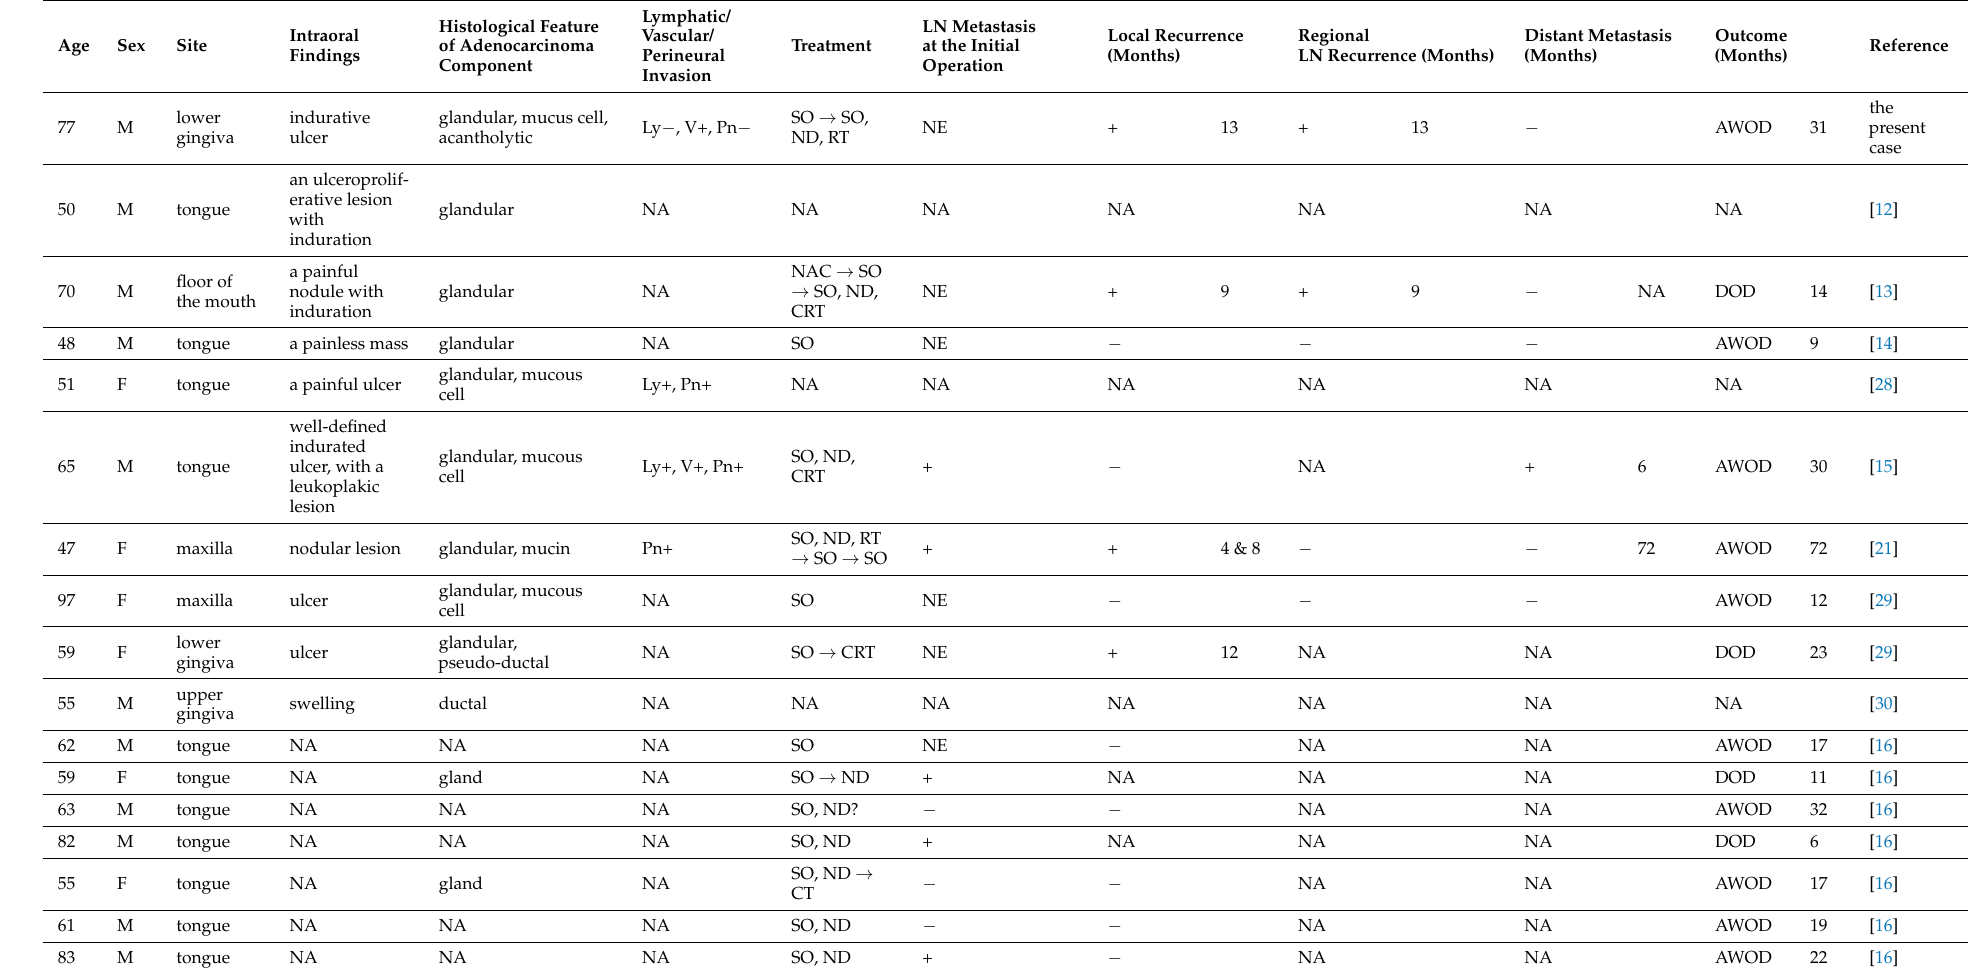
Table 1. A comprehensive review of cases of adenosquamous cell carcinoma in the oral